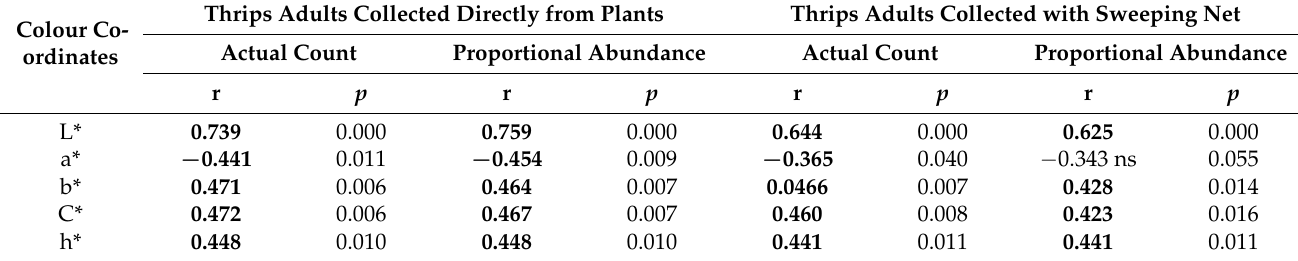
Table 5. Pearson’s correlation between colorimetric characteristics of onion leaves and actual count and proportional abundance of adults Thrips tabaci in 2015 (n = 32). Colour Co-